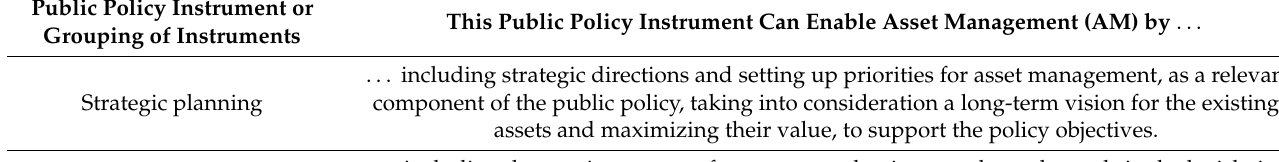
Table 7. Public policy instruments and how they may enable asset management